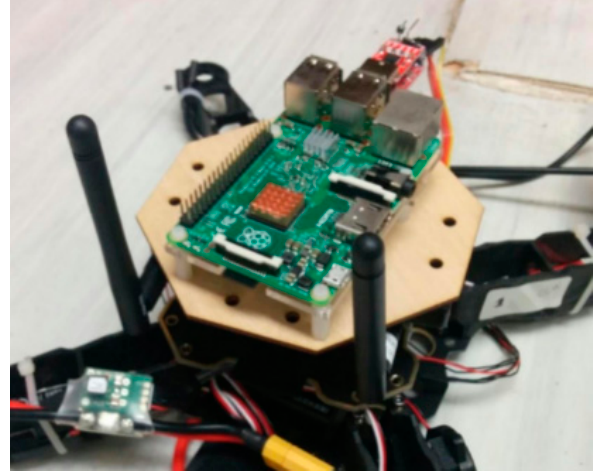
Figure 8. Onboard computer module.